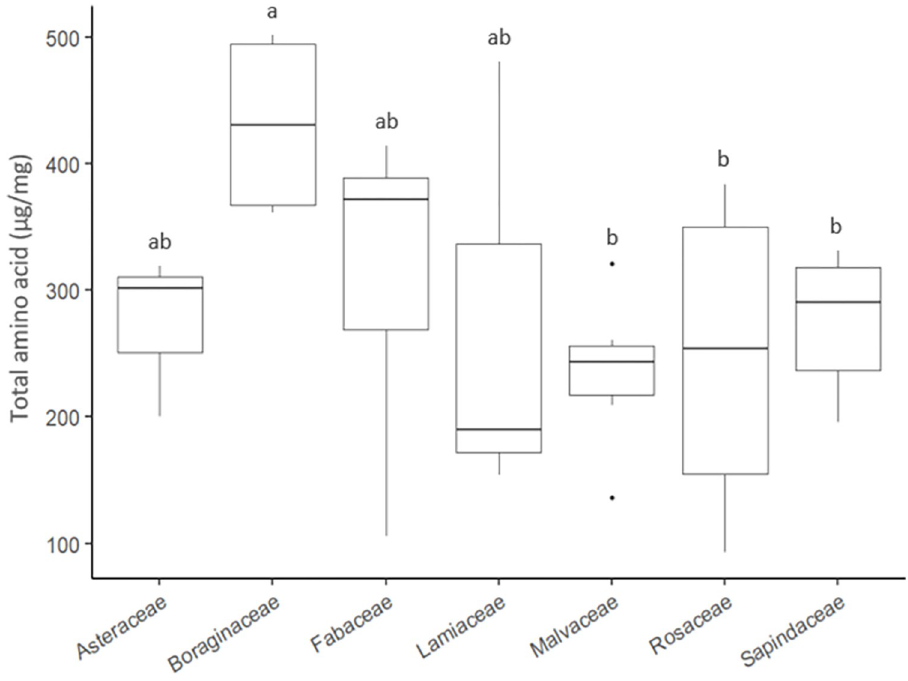
Fig 1. Boxplot of total amino acids per plant